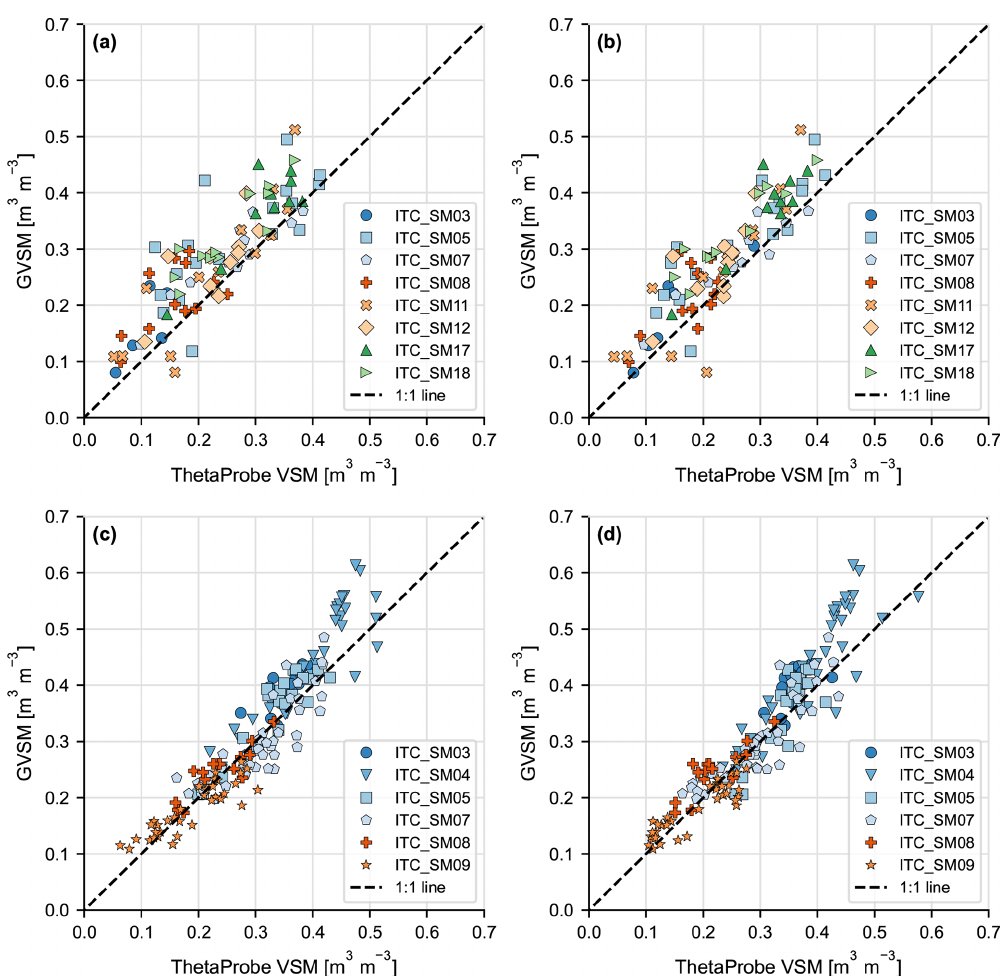
Figure 6. Scatterplots of the ThetaProbe VSM against GVSM collected during the 2009 (a, b) and 2015 (c, d) field campaigns. In subplots (a) and (c) are the ThetaProbe VSM readings taken next to a GVSM measurement. In subplots (b) and (d) are the mean of the ThetaProbe VSM readings taken at a sampling